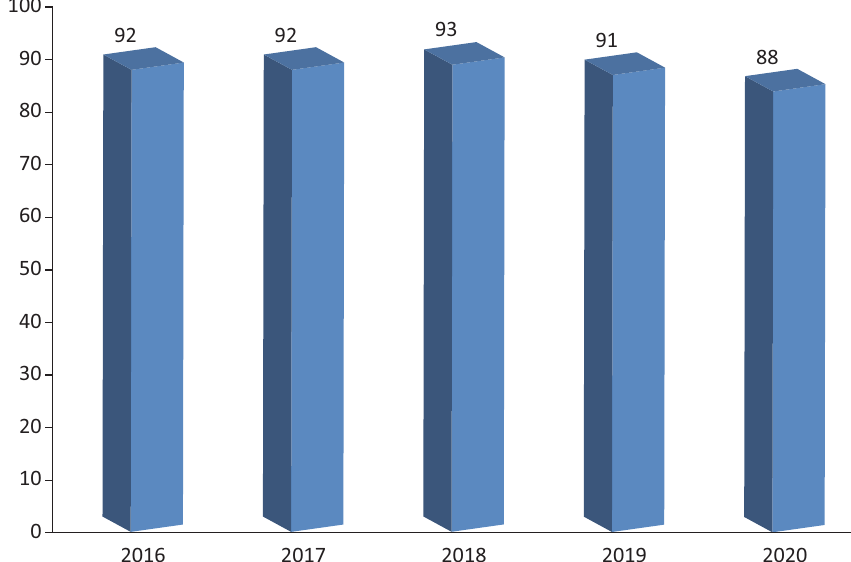
Figure 1. Share of internet users who watched TV at least once during the last two weeks. Source: Deloitte (2020). Media and Communication, 2021, Volume 9, Issue 4, Pages